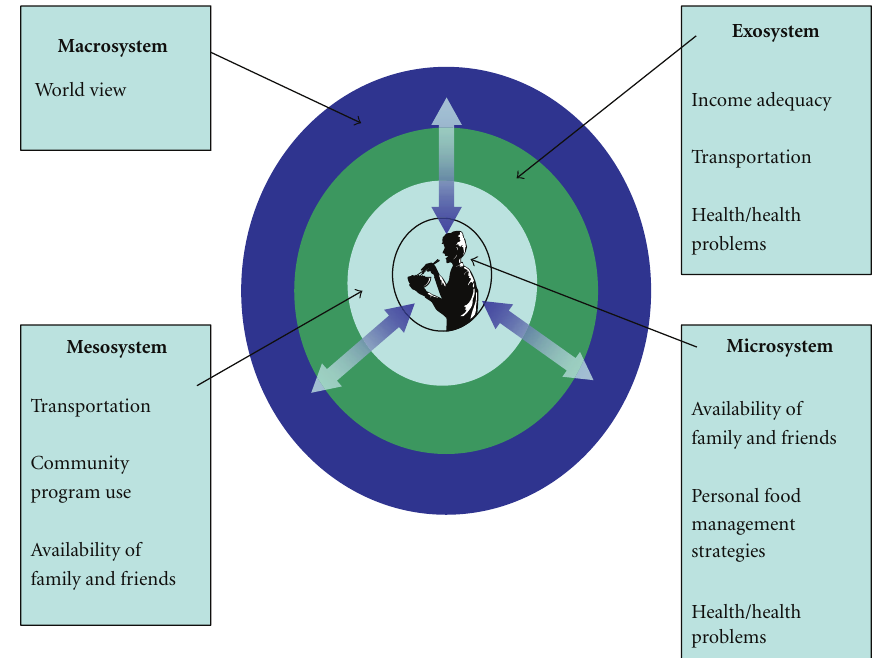
Figure 1: How low-income lone senior women living in NS experience food security, organized according to Bronfenbrenner’s Ecological